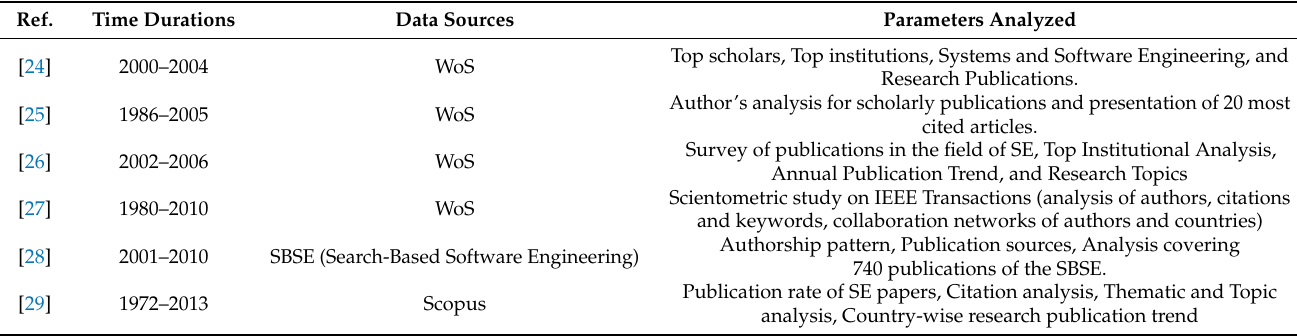
Table 1. Significant bibliometric work in the field of Software Engineering.